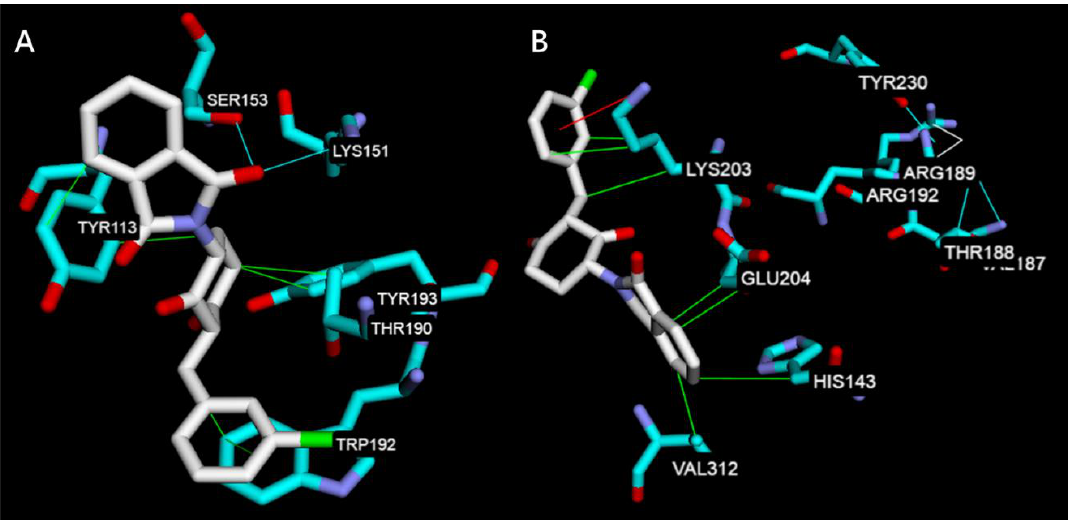
Figure 8. Docking poses of compound 5c at the ( A ) ERK2 (PDB code 2Y9Q) and ( B ) JNK-1 (PDB code 3PZE). The interaction illustrated by green lines represents hydrophobic interaction, blue lines represent hydrogen bonding and red line represents pi-cation.